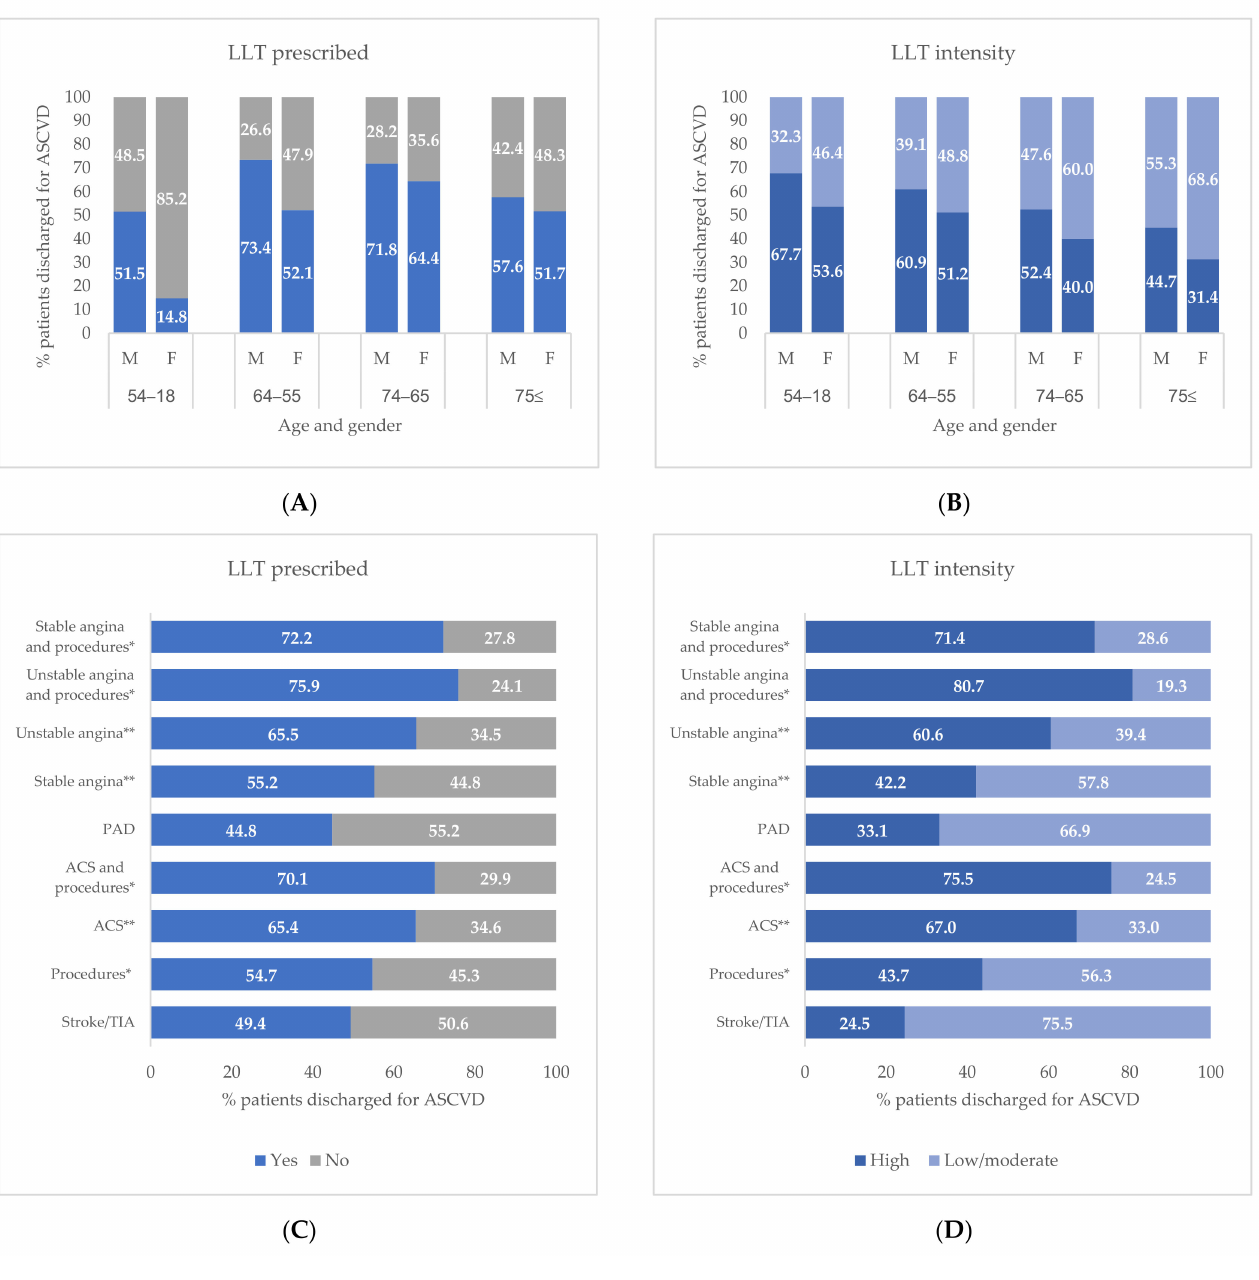
Figure 3. Lipid Lowering Therapy (LLT) in ASCVD patients within 6 months from the discharge stratified by sex and age ( A ) and ASCVD condition ( B ). Type of Lipid Lowering Therapy (LLT) in ASCVD patients within 6 months from the discharge stratified by sex and age ( C ) and ASCVD condition ( D ). * Procedures including percutaneous coronary intervention, coronary artery bypass surgery, or other revascularization procedures. ** Without procedures. Abbreviations: ACS, acute coronary syndrome; ASCVD, atherosclerotic cardiovascular disease; PAD, peripheral arterial disease; TIA, transient ischemic